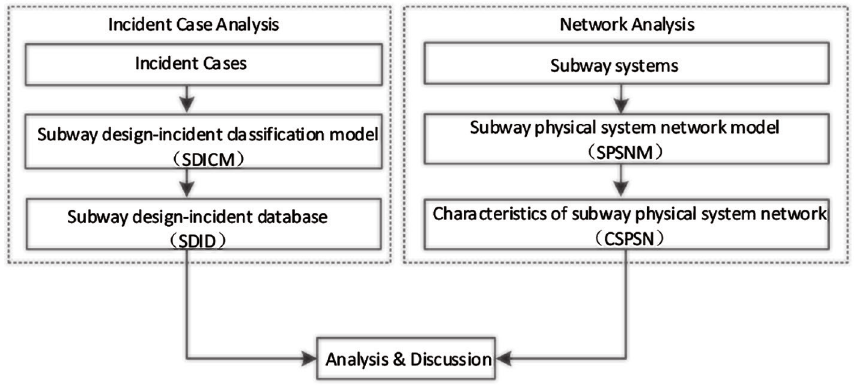
Figure 2. Research